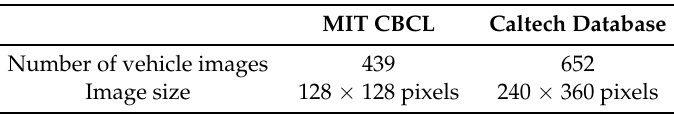
Table 2. Used public